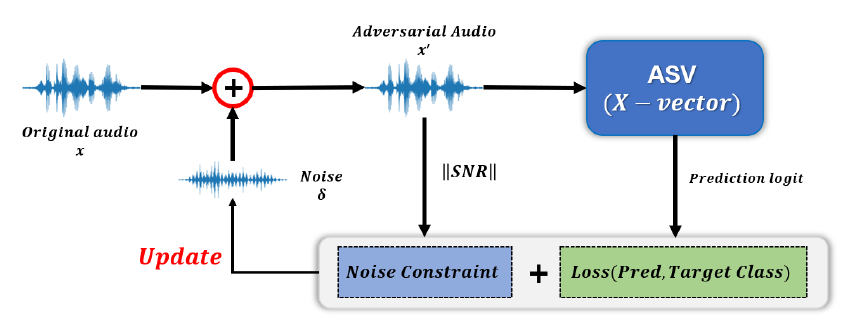
Figure 6. Diagram of optimization-based